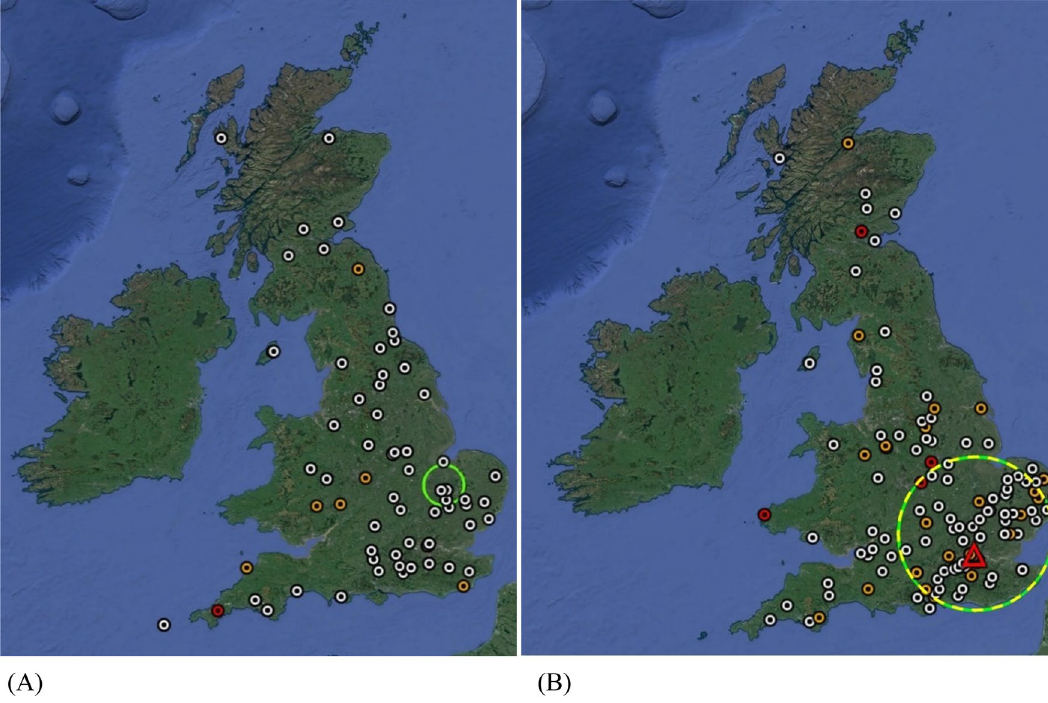
Figure 3. Distribution of disease incident reports (DIRs) in Eurasian blackbirds ( Turdus merula ) from Great Britain, June -November inclusive, 2019 ( A ; n = 56) and 2020 ( B ; n = 120). Red circles represent DIRs consistent with neurological disease; orange circles represent DIRs involving blackbirds exhibiting signs of generalised ill health; white circles represent all other morbidity and/or mortality DIRs (removing categories where USUV could reasonably be excluded as the cause i.e. avian pox, nestling mortality, beak and plumage abnormality); red triangle denotes site of confirmed USUV infection. Green circle ( A , 2019) indicates statistically significant cluster of reports, accounting for heterogeneity in blackbird population density. Hatched circle ( B , 2020) indicates statistically significant cluster of reports, accounting for spatial heterogeneity in surveillance effort by using number of sites from which passerine DIRs were submitted in each county (yellow) and for heterogeneity in blackbird population density (green); clusters are of identical size and location. Map created with Google Earth Pro. Version 7.3.3.7699 (2020) (https:// www. google. com/ intl/ en_ uk/ earth/ versi ons/# earth-